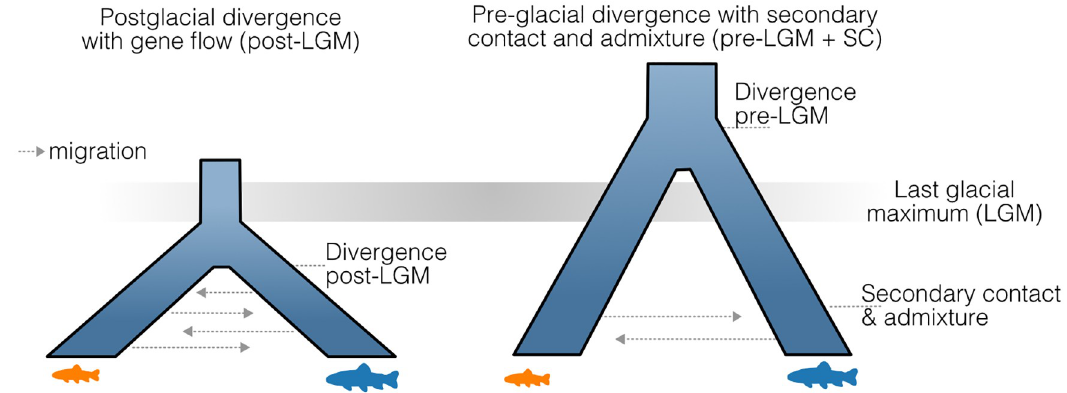
Fig 4. Evolutionary histories of sympatric ecotype pairs. Illustrations of the two categorical classifications of evolutionary histories based on cumulative evidence from demographic models and genetic ancestry analyses.